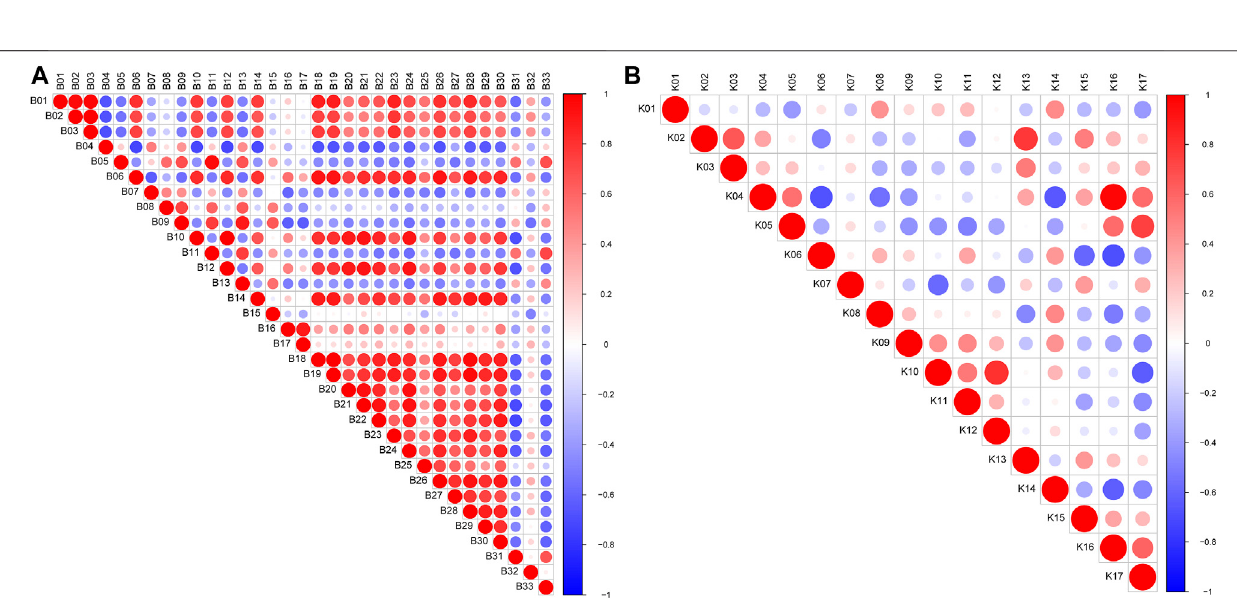
Frontiers in Pharmacology |